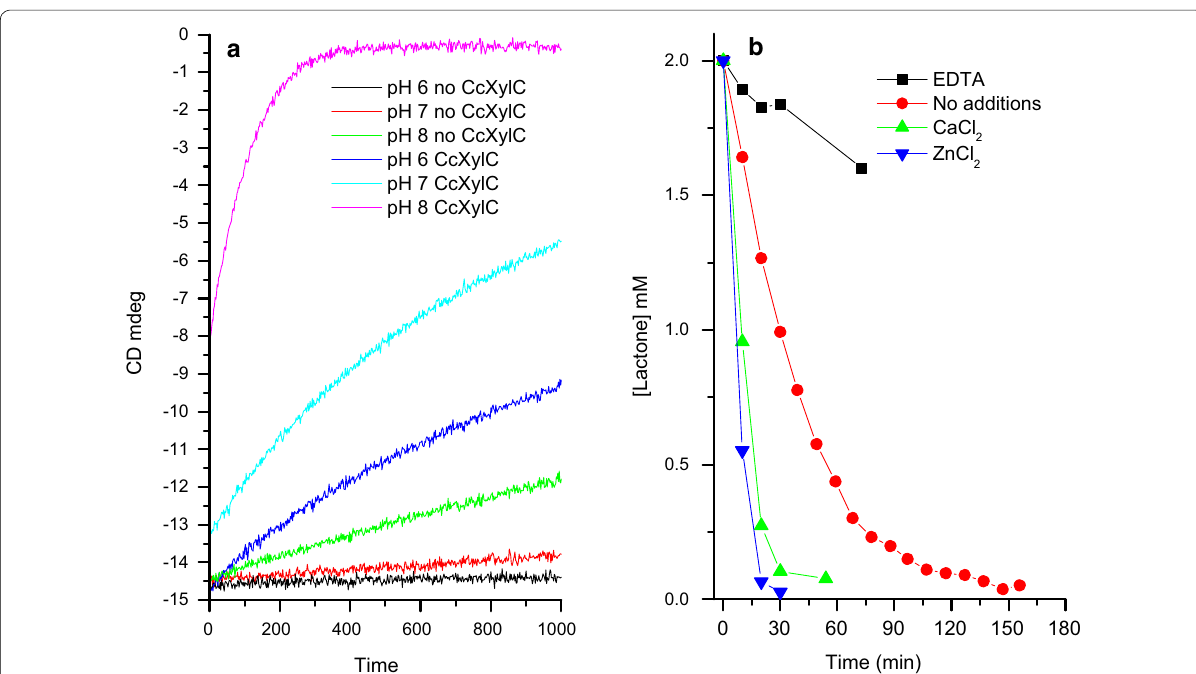
Fig. 3 a pH dependency of the Cc XylC lactonase measured using circular dichroism. A circular dichroism (CD)—based assay for lactonase activity was performed in 10 mM Tris–HCl buffer, pH 6–8, using 1 mM lactone and 3.4 µg of enzyme (in case it was added to the reaction) in 300 µL buffer. b NMR based Cc XylC lactonase activity measurements. The reactions for NMR were carried out in 600 µl of 50 mM Na-phosphate buffer, pH 6.8 at 22 °C containing 10% of D 2 O using 2 mM xylonolactone with 100 µM metal ions or EDTA. After recording a zero spectrum 10 µg of Cc XylC was